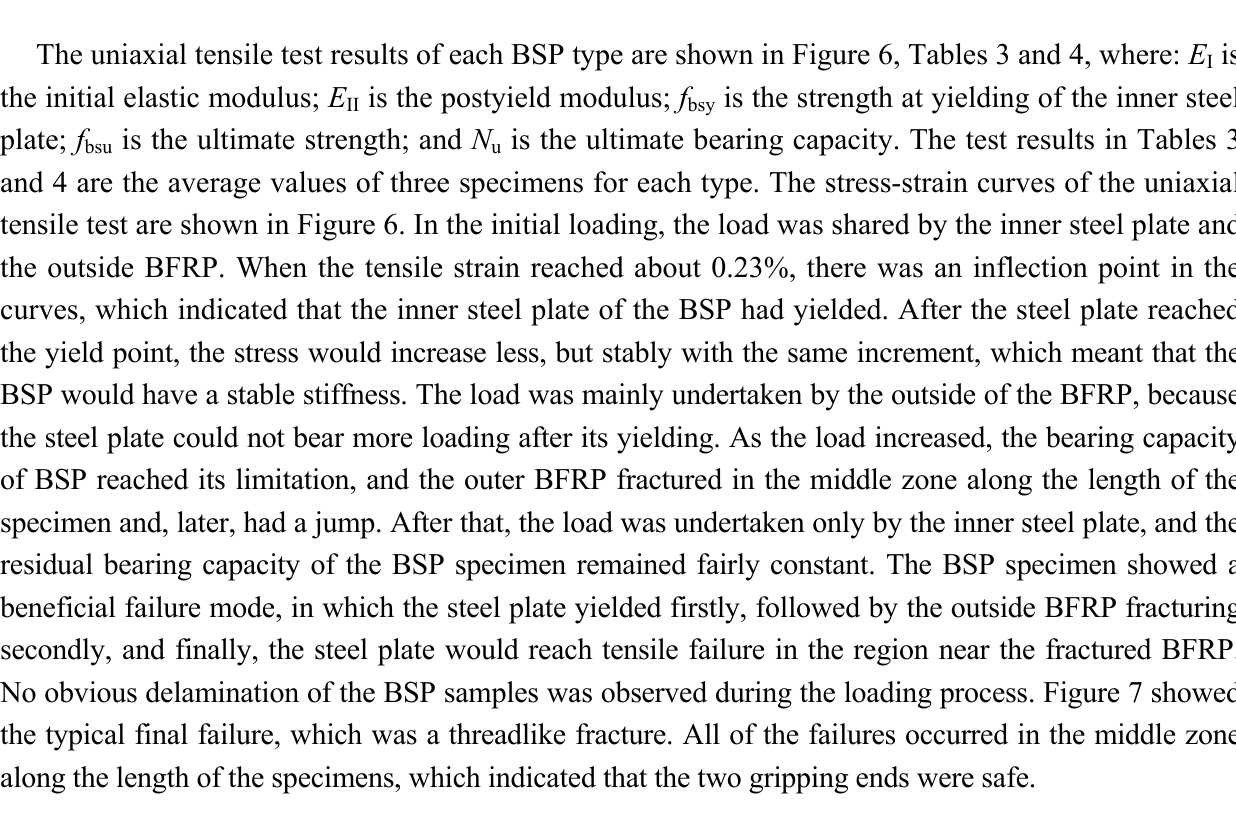
Figure 6. Stress-strain curves of BSP under uniaxial tension: ( a ) BSP2; ( b ) BSP4; ( c ) BSP6; and ( d )